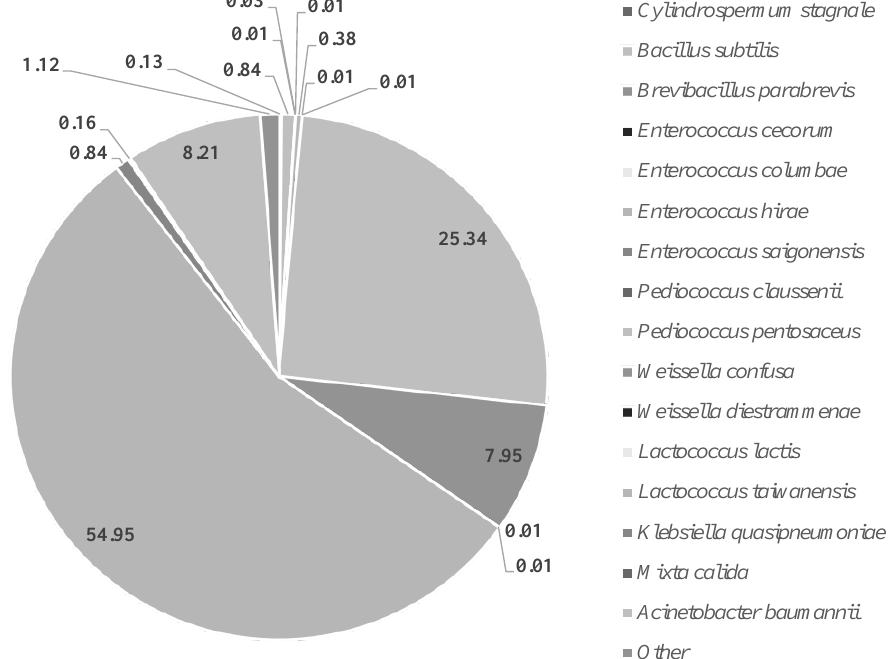
Figure 4. Bacterial profile (composition expressed in %) detected in the spontaneously fermented Lens culinaris Medik. material.